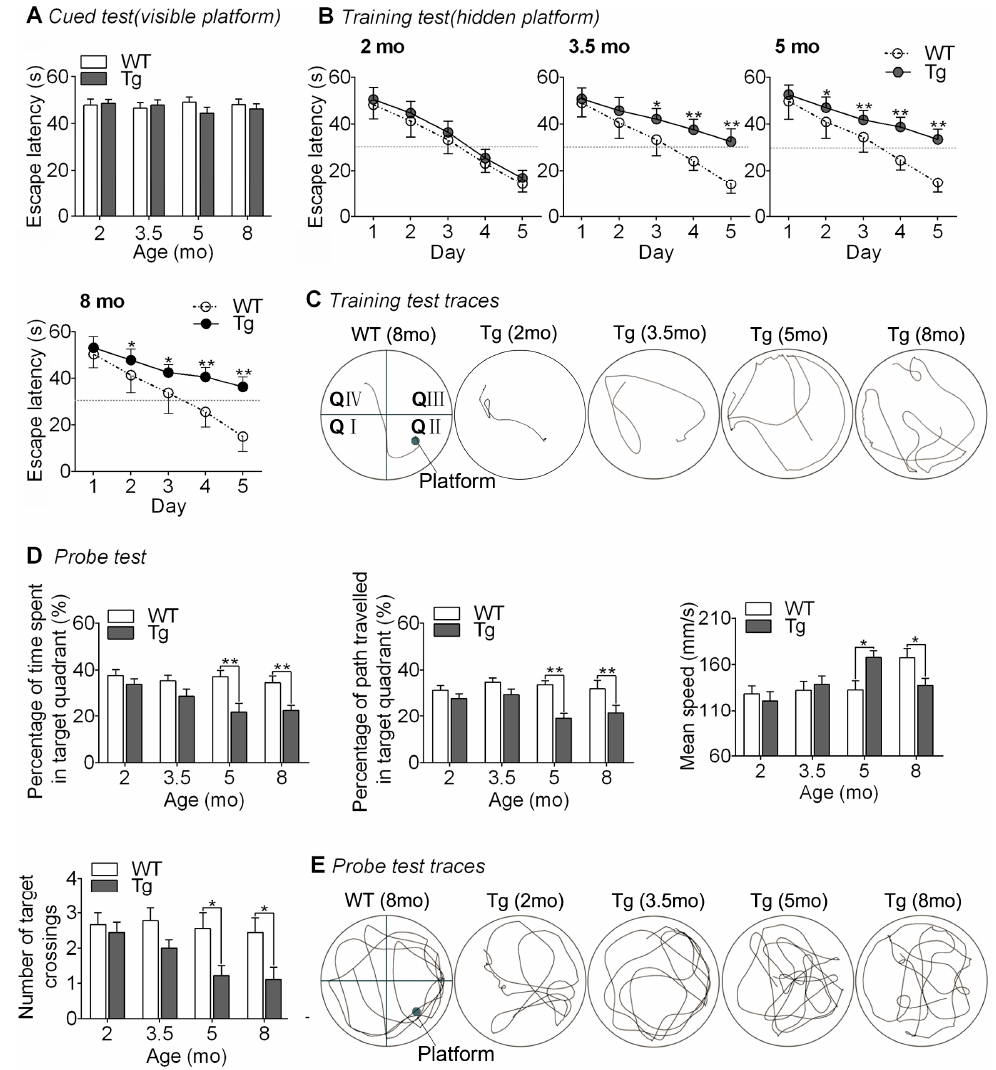
Figure 2. Morris water maze (MWM) results. ( A ) Comparisons of escape latencies in the cued test between Tg and wide-type (WT) mice aged 2, 3.5, 5 and 8 mo; ( B ) Escape latencies in 5 days in the training test and ( C ) typical training traces (the fifth day) for mice of each age. (* p < 0.05; ** p < 0.01; vs. aged-matched WT mice); ( D ) Comparisons of the percentage of time spent in the target quadrant, percentage of path travelled in the target quadrant, mean speed, as well as number of target crossings in the probe test between Tg and WT mice aged 2, 3.5, 5 and 8 mo; and ( E ) typical probe traces. (* p < 0.05; ** p < 0.01; vs. aged-matched WT mice). mo: month-old. The training tests were used to assess spatial learning. Tg mice aged 2 mo (month-old)